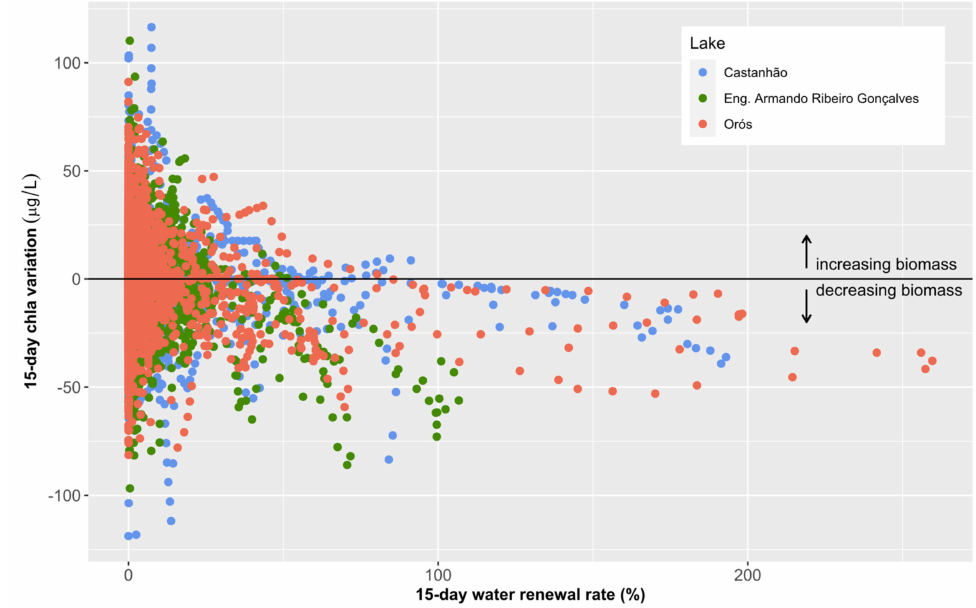
Figure 6. Chlorophyll a (chla) variation in 15-day periods as a function of the water renewal rate, calculated as the total water inflow divided by the median stored volume in the same